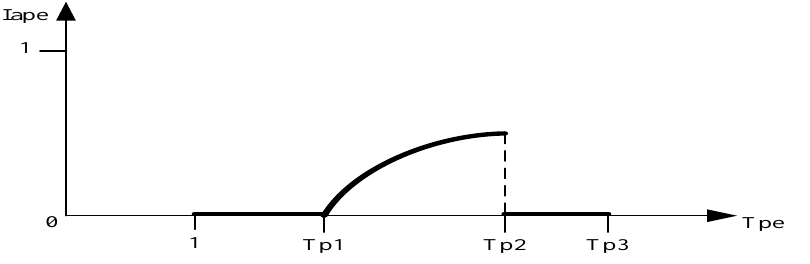
Figure 4. Schematic representation of dependence of the indicator of adaptability of the enterprise to the increase of prices for a certain type of energy resources I ape from the growth rate T pe .